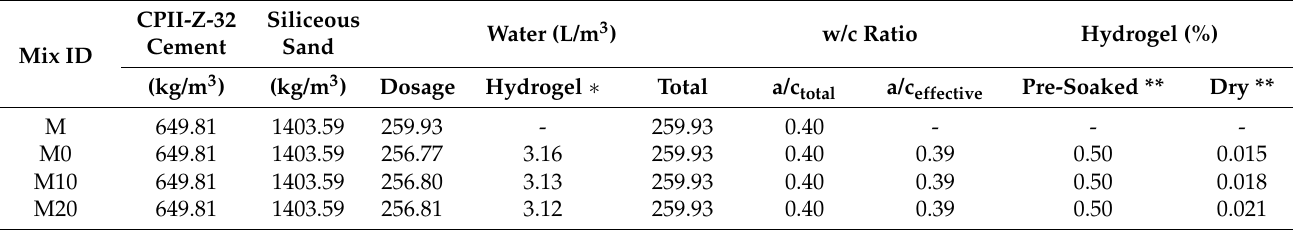
Table 3. Design of mix proportion of mortars